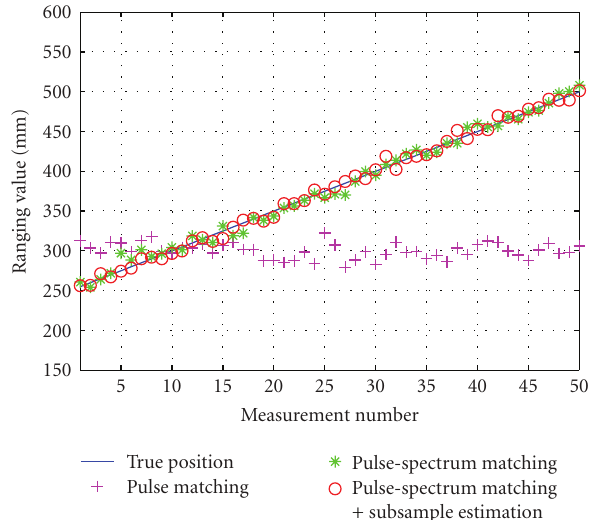
Figure 13: Evaluation of the ranging algorithms without the clutter map removal.